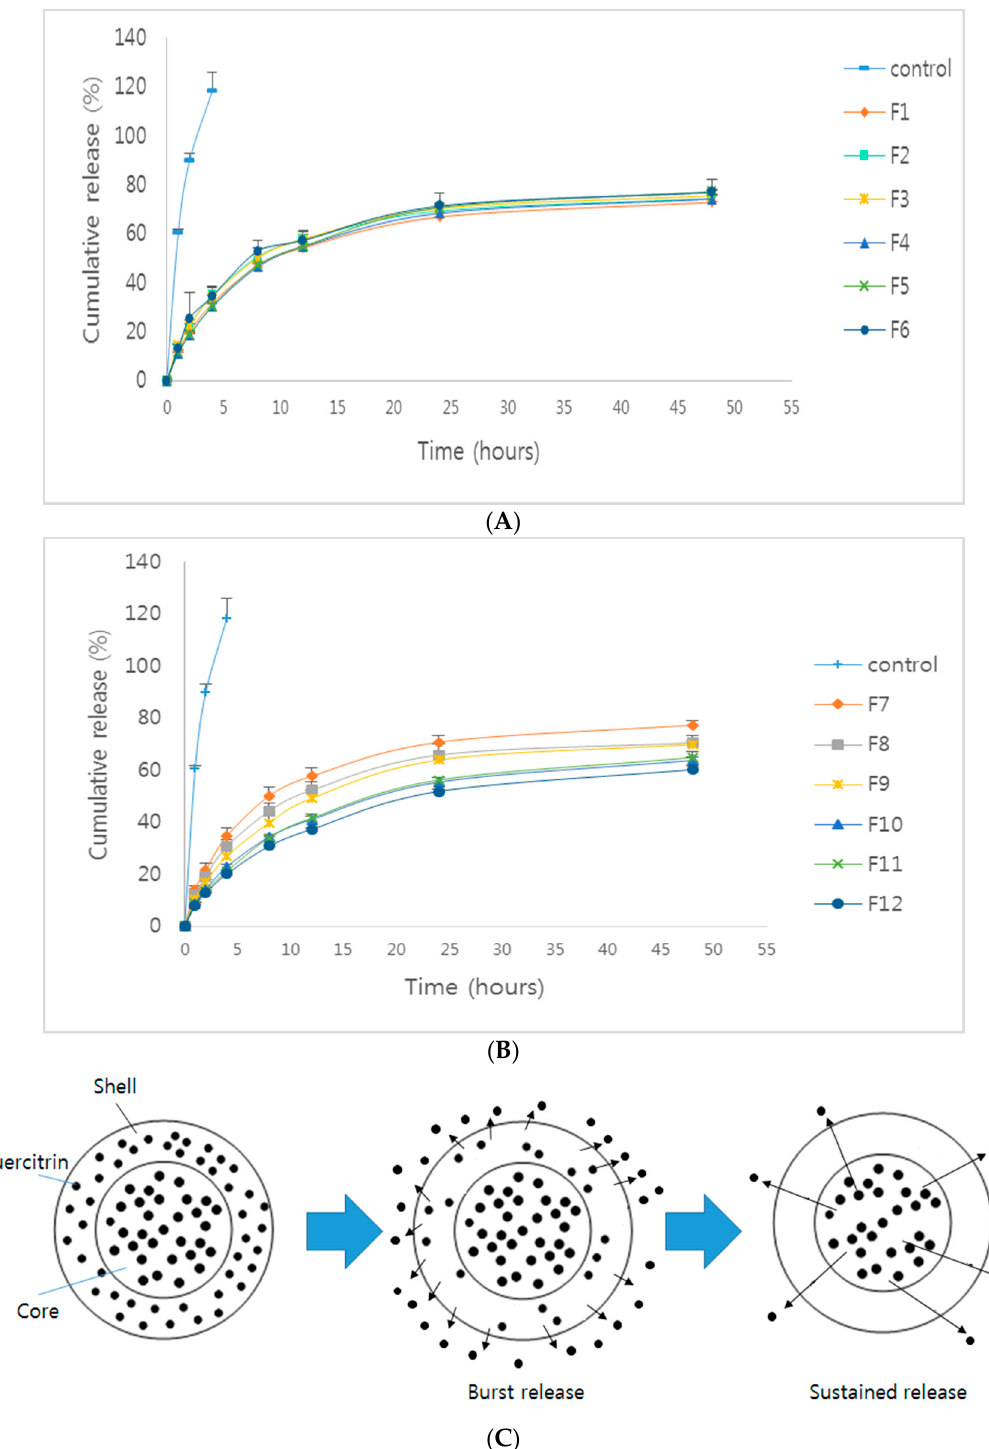
Figure 5. In vitro release of all formulations (1% tween 80, pH 7.4). ( A ) F1–F6; ( B ) F7–F12 and ( C ) Schematic drawing of the proposed release mechanism of drug from solid lipid nanoparticles.